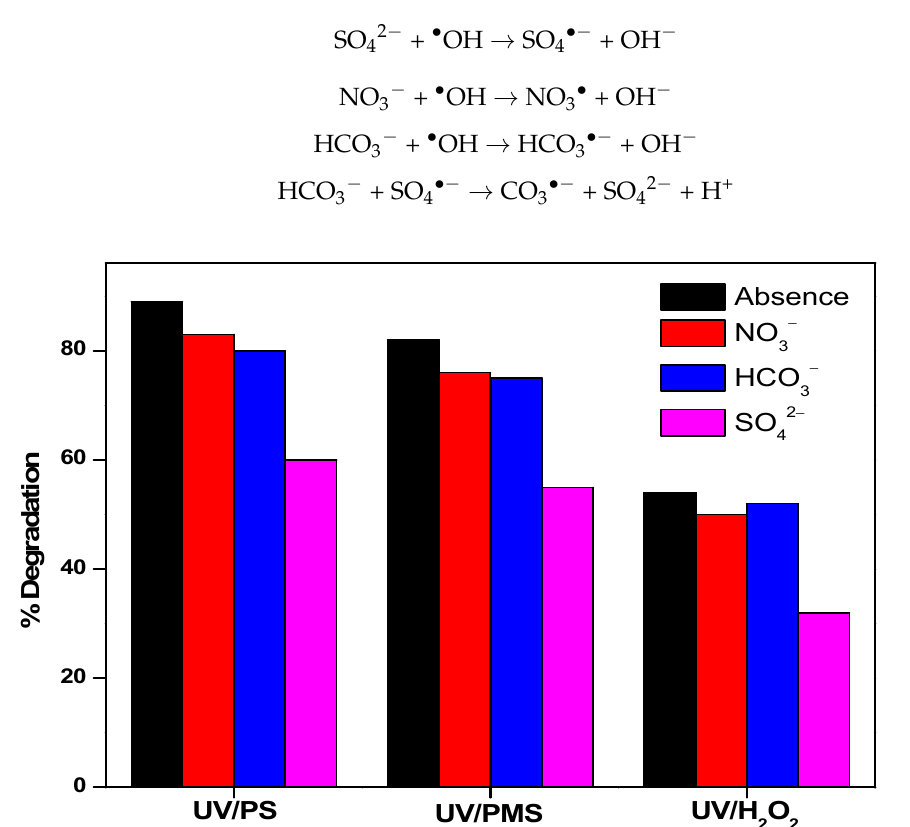
Figure 7. The effect of inorganic anions on the degradation efficiency of DCF sodium by using the Fe 2+ /H 2 O 2 , Fe 2+ /PS and Fe 2+ /PMS systems. Reaction conditions: [Anions] 0 = 10 mM, [DCF sodium] 0 = 0.5 mM, [Fe 2+ ] 0 = 0.5 mM, [H 2 O 2 ] 0 = [PS] 0 = [PMS] 0 = 10 mM, pH = 4.